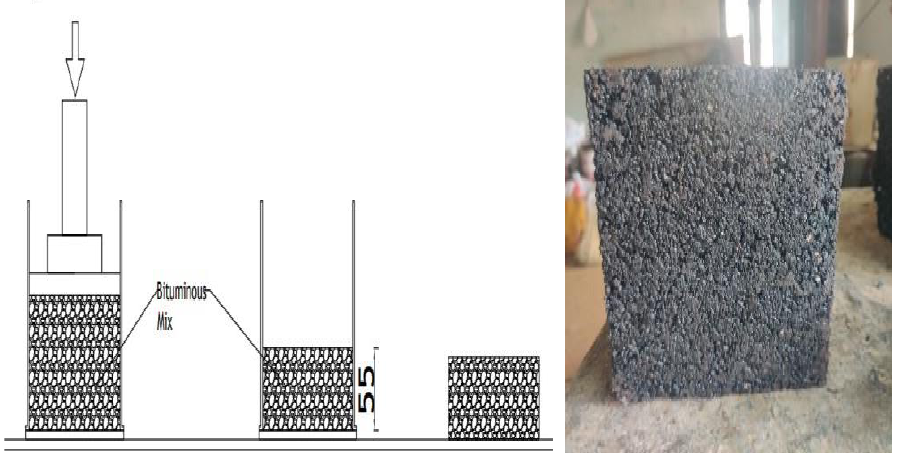
Figure 2. Bituminous